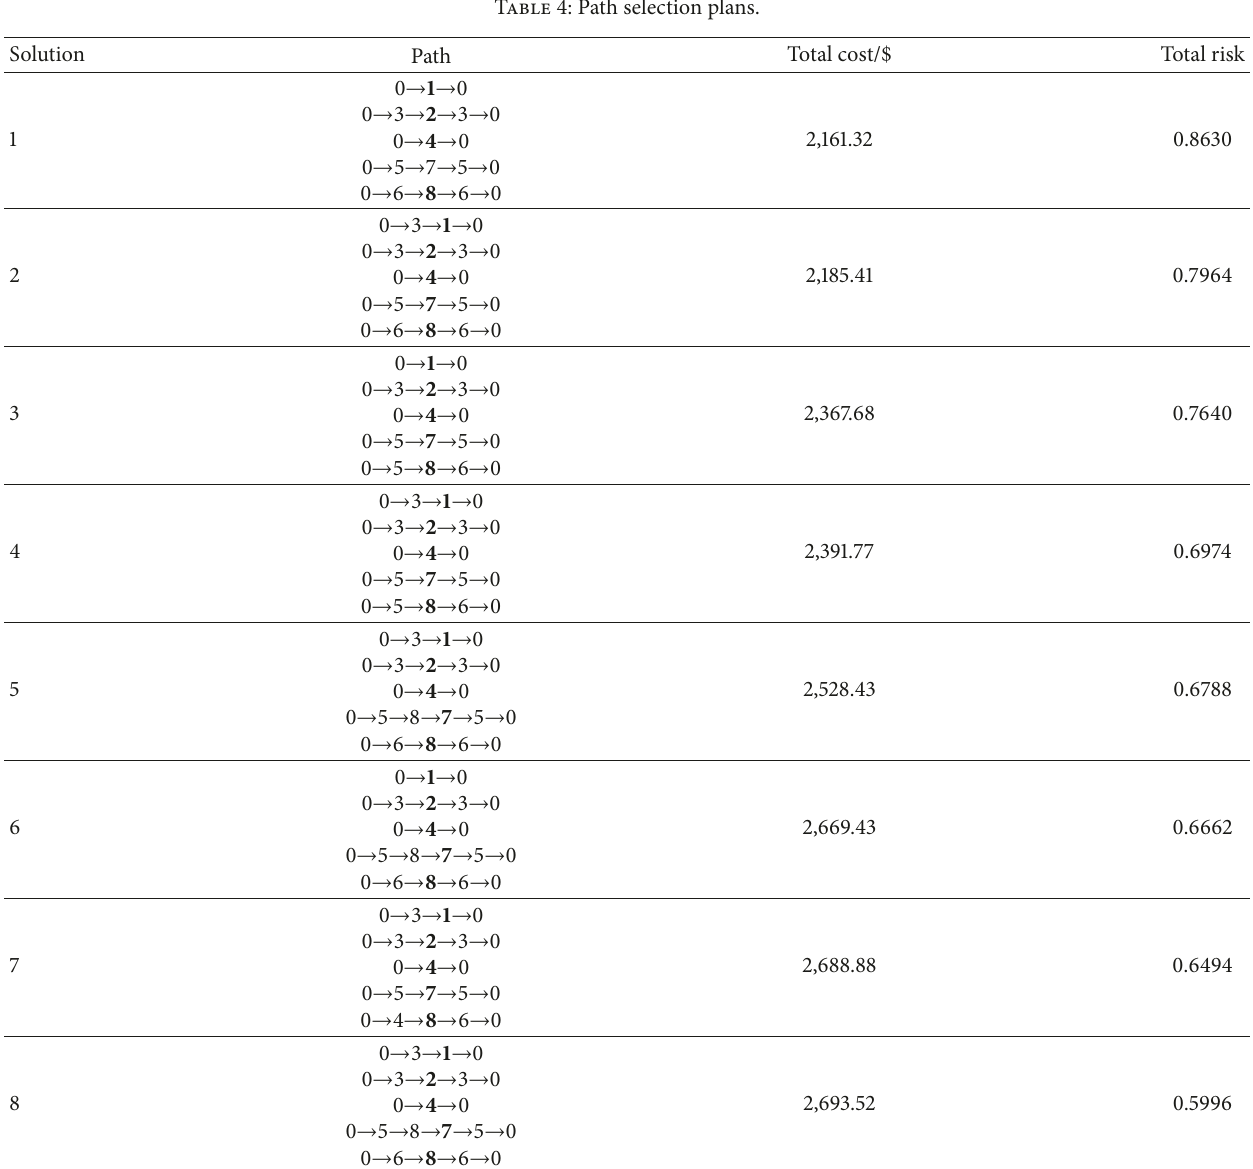
Table 4: Path selection